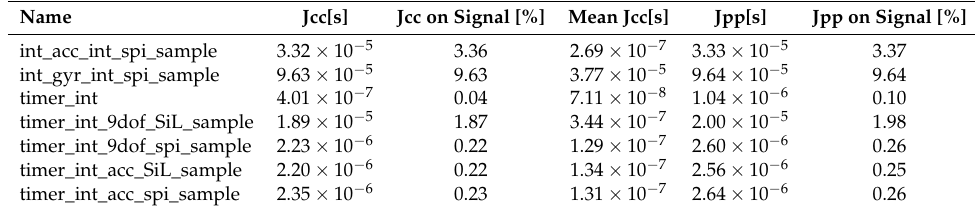
Table 6. Cycle-to-Cycle-Jitter with optimization (-O3).